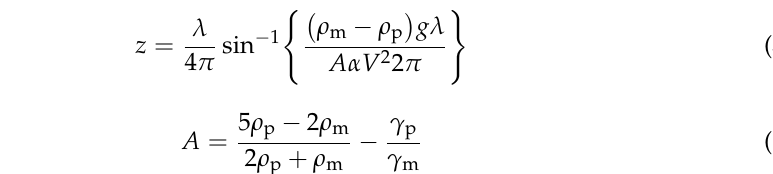
Figure 5. Schematic representation of MagLev for detection of protein based on the magnetic sus- ceptibility change. Reproduced from Ref. [68] with permission. Copyright 2020 American Chemical Society.